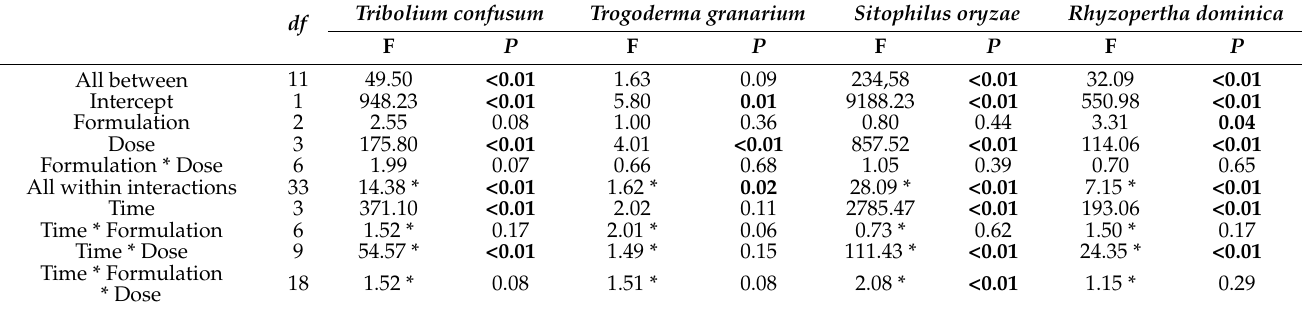
Table 2. Repeated measures MANOVA parameters for mortality of the tested species exposed to three different dust formulations (D1, D2, and W) and four concentration rates (500, 1000, 2000 ppm, and control) [total degrees of freedom (df) = 96 ]. * Wilks’ Lamda approximate F